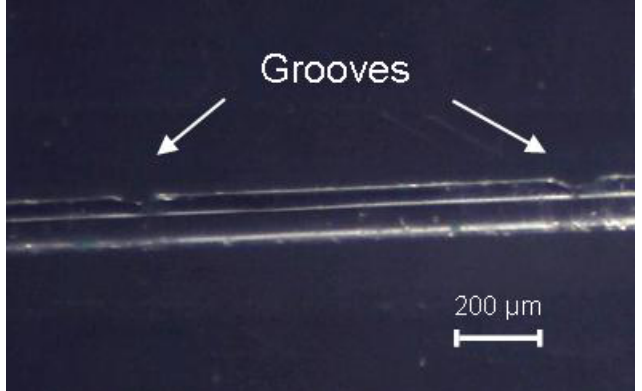
Figure 7. Picture showing two consecutive unsymmetrical changes in the cladding thickness produced by MIR CO laser irradiation of a Corning SMF-28 fiber. (Cylindrical 2 lens, exposure time 40 ms, 9 W laser power).